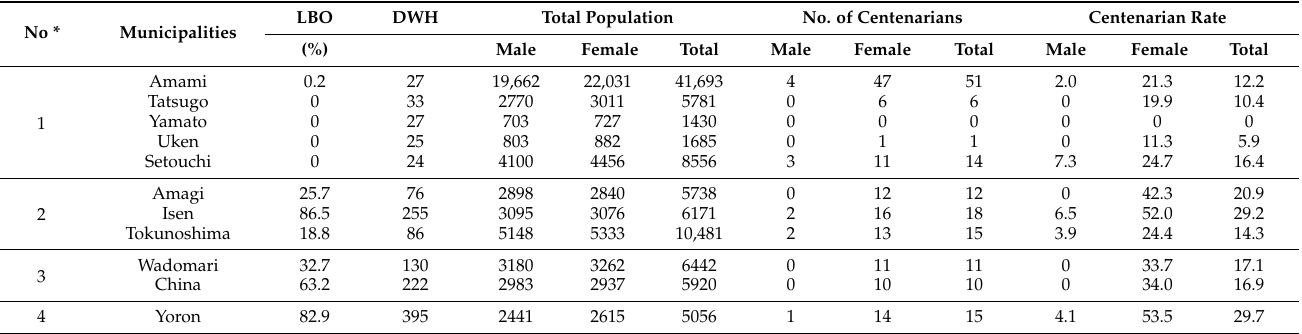
* Number indicates each island as shown in Figure 1. (1 = Amami-Oshima; 2 = Tokunoshima; 3 = Okinoerabu; 4 = Yoron). Centenarian rate is shown as number/10,000 population.